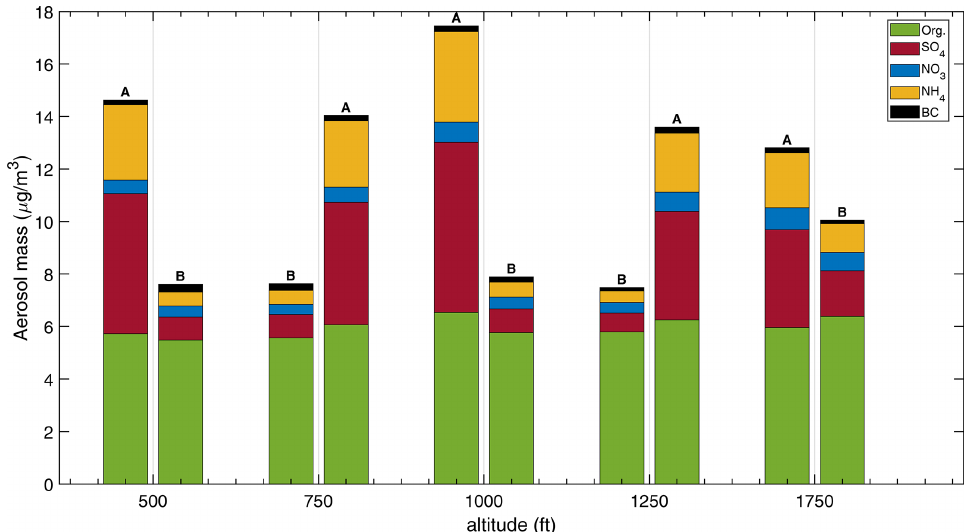
Figure 4. Particle chemical composition for plumes A and B during screen 1 of the 9 June transformation flight.